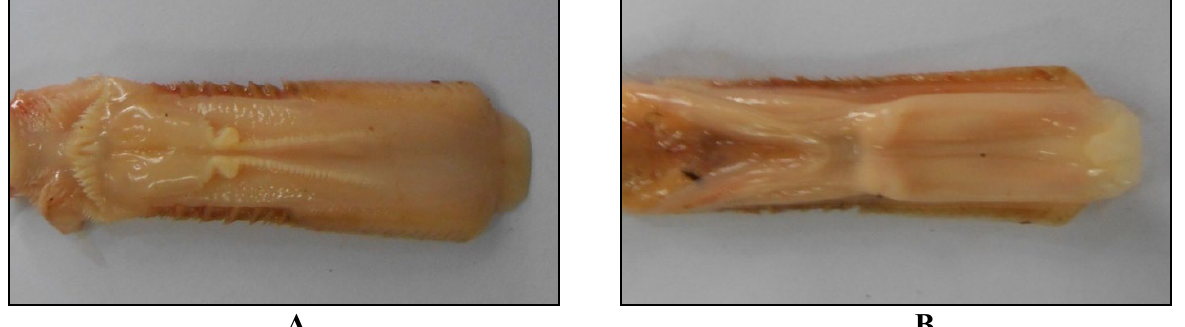
A B Fig. 4. Photograph of the dorsal (A) and ventral (B) surface of the tongue of the Khaki Campbell duck at two months of age